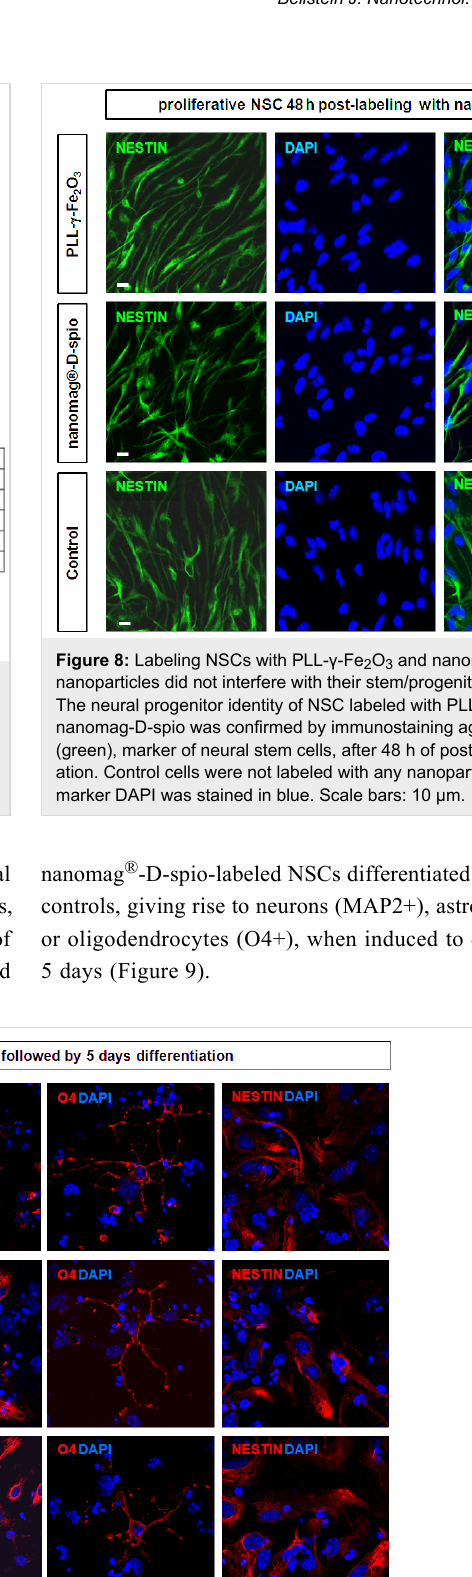
Figure 9: NSCs labeled with PLL- γ -Fe 2 O 3 and nanomag ® -D-spio nanoparticles differentiate into all three major neural cell lines. Following 48 h of nanoparticle incubation, NSCs labeled with PLL- γ -Fe 2 O 3 or nanomag-D-spio were differentiated for 5 days and compared to the unlabeled controls. Neurons (MAP2+), astrocytes (GFAP+) and oligodendrocytes (04+) (all red) could be identified in all conditions. Nuclear marker DAPI was stained in green. Scale bars: 10 µm.